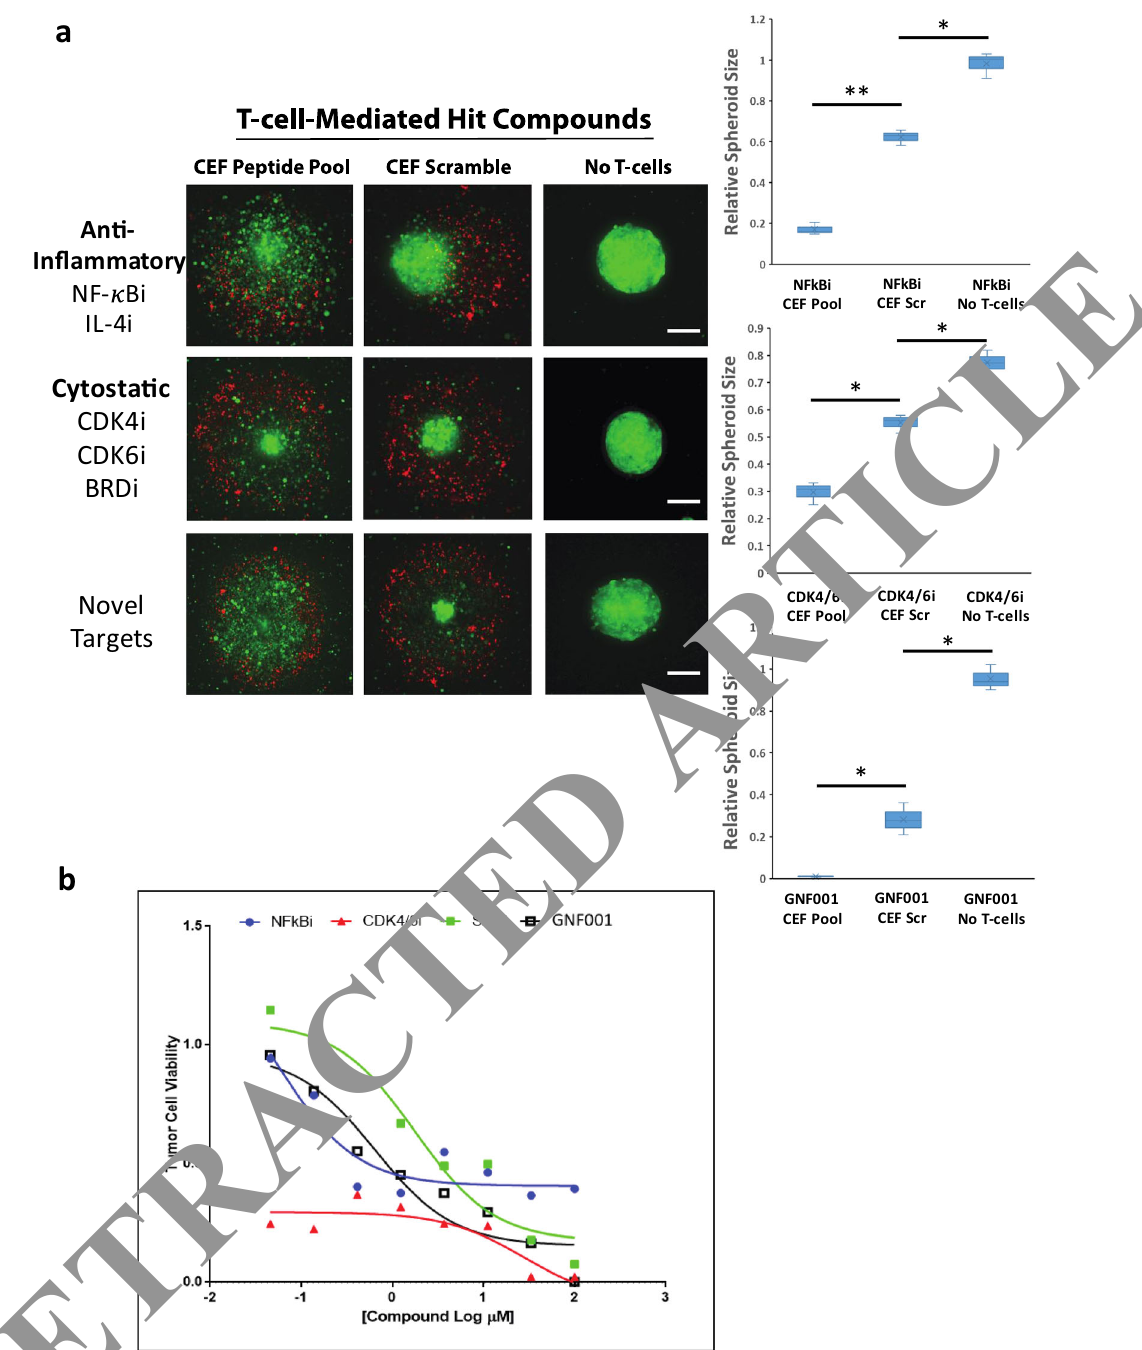
Fig. 5 Hit compounds that synergized with T-cells to manifest phenotypes. a Hit compounds from the primary screen were tested on T-cell/spheroid co- cultures where both cell types were primed with the same antigen (CEF Peptide Pool), cell types were primed with different antigens (CEF Scramble) or spheroid monocultures with no T-cells (No T-cells). Anti-in fl ammatory compounds (NF- κ B and IL-4 inhibitors) were shown to enhance T-cell spheroid- killing properties, where antigen-dependent interactions signi fi cantly increased compound ef fi cacies. Other compounds, such as CDK4/6 or BRD inhibitors, demonstrated enhanced T-cell anti-tumor function in a mainly antigen-independent manner (Cytostatic). Several compounds targeting novel proteins not reportedly associated with enhanced T-cell cytotoxicity demonstrated potent antigen-dependent phenotypes. Spheroid sizes are quantitated in bar graphs on right, relative to DMSO controls. Scale bars indicate 100 µ m. An independent sample t-test was used to calculate probability where * p < 0.05, ** p < 0.01; n = 3 biologically independent samples and error bars represent standard deviation. b Viability readout of spheroids from a using HCT116-Luc reporter spheroids in the presence of T-cells and hit compounds with matching viral antigens (CEF Peptide Pool). NF- κ B inhibitor demonstrated toxicity but limited potency, while the CDK4/6 inhibitor showed a predictably cytostatic response. Sonic Hedgehog inhibitor (SHHi, Cyclopamine), as well as a compound targeting an unidenti fi ed protein (GNF001), demonstrated high potencies and sigmoidal dose – response